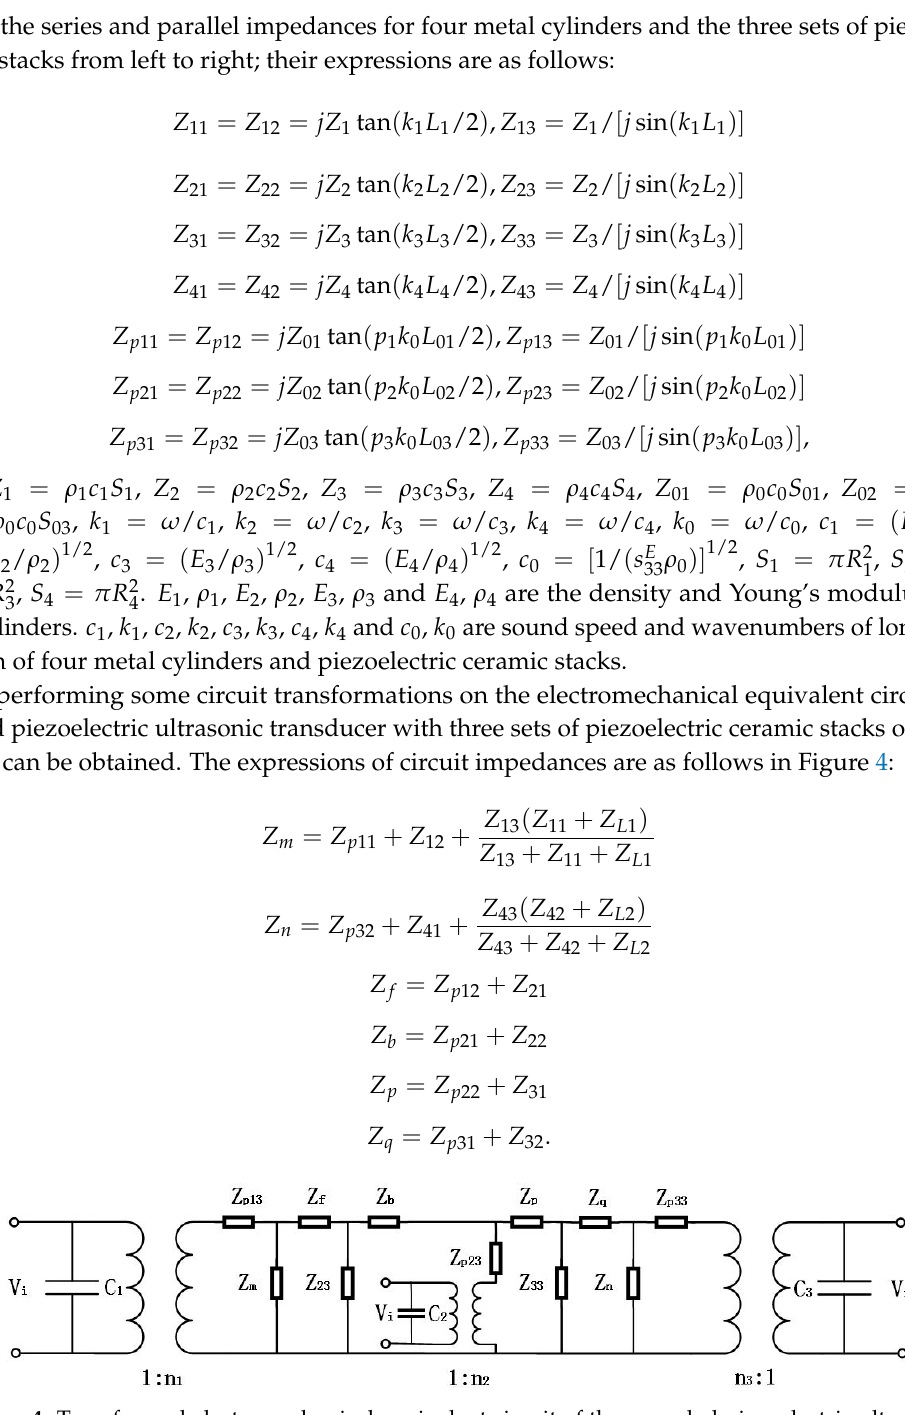
Figure 4. Transformed electromechanical equivalent circuit of the cascaded piezoelectric ultrasonic transducer with three sets of piezoelectric ceramic